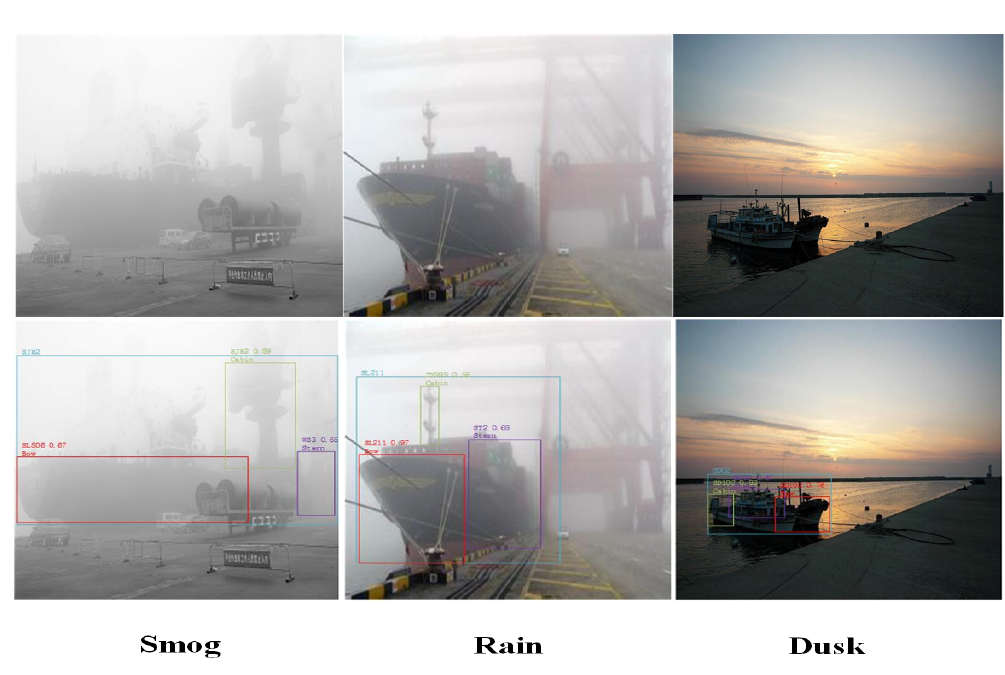
Figure 7. Ships in bad weather: The top is the ships in bad weather, and the bottom is the process